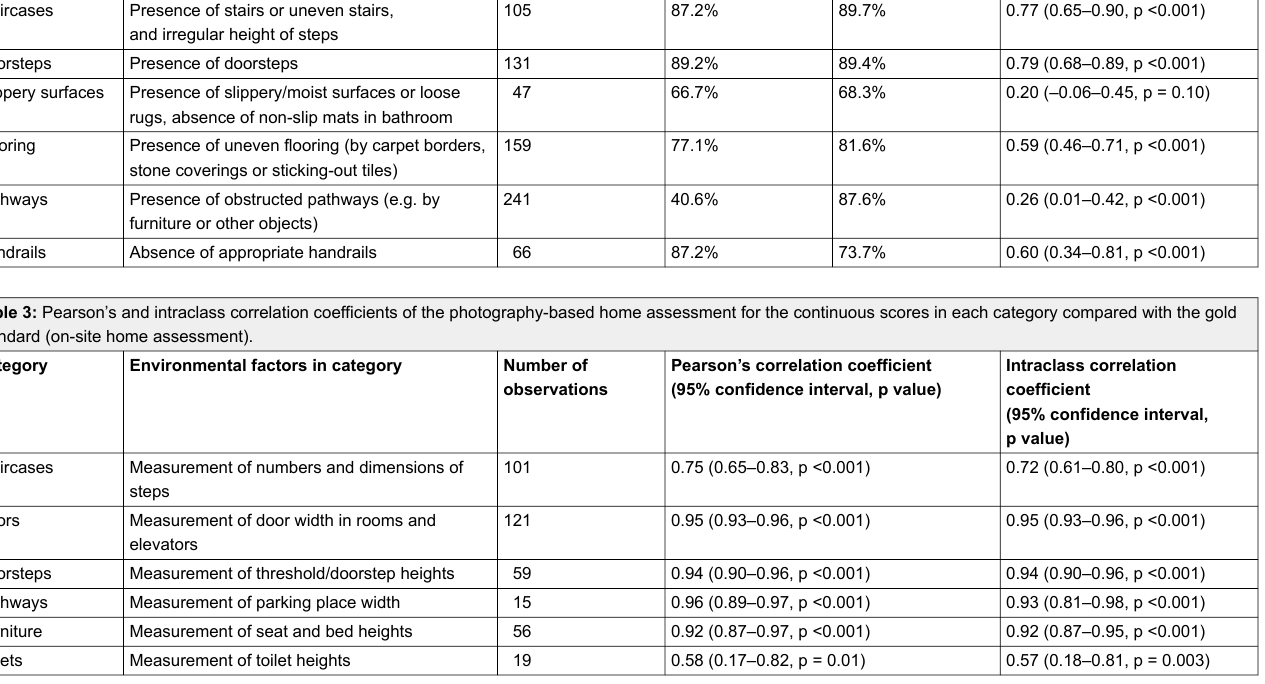
Sensitivity observations